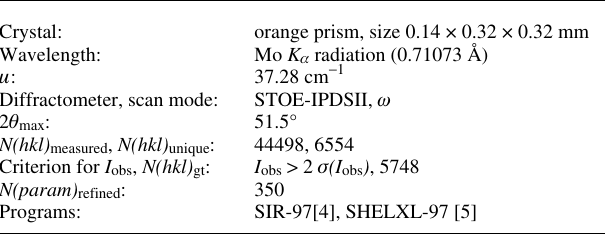
Table 1. Data collection and handling.